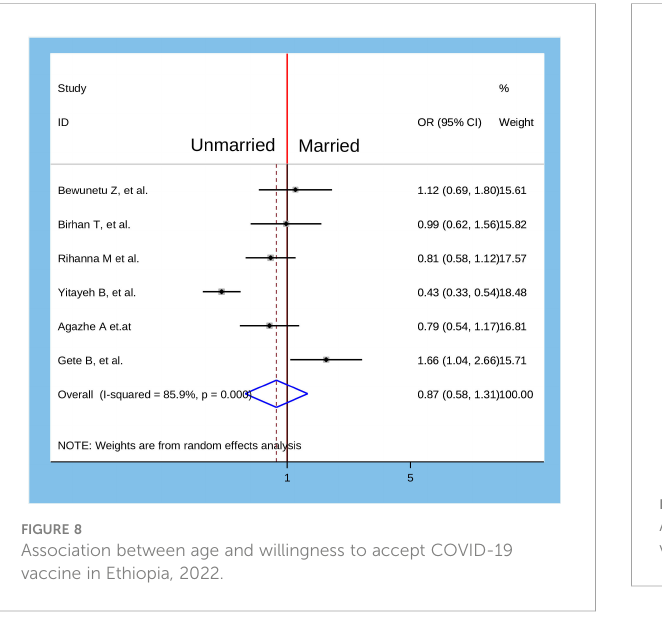
FIGURE 10 Association between residence and willingness to accept COVID-19 vaccine in Ethiopia, 2022.